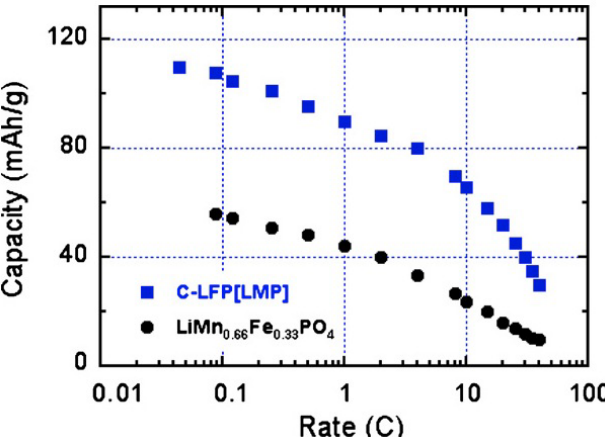
Figure 6. Modified Peukert plot for the C-LiFePO samples for comparison. (Reprinted with permission from [59]. Copyright 2012 Elsevier.)